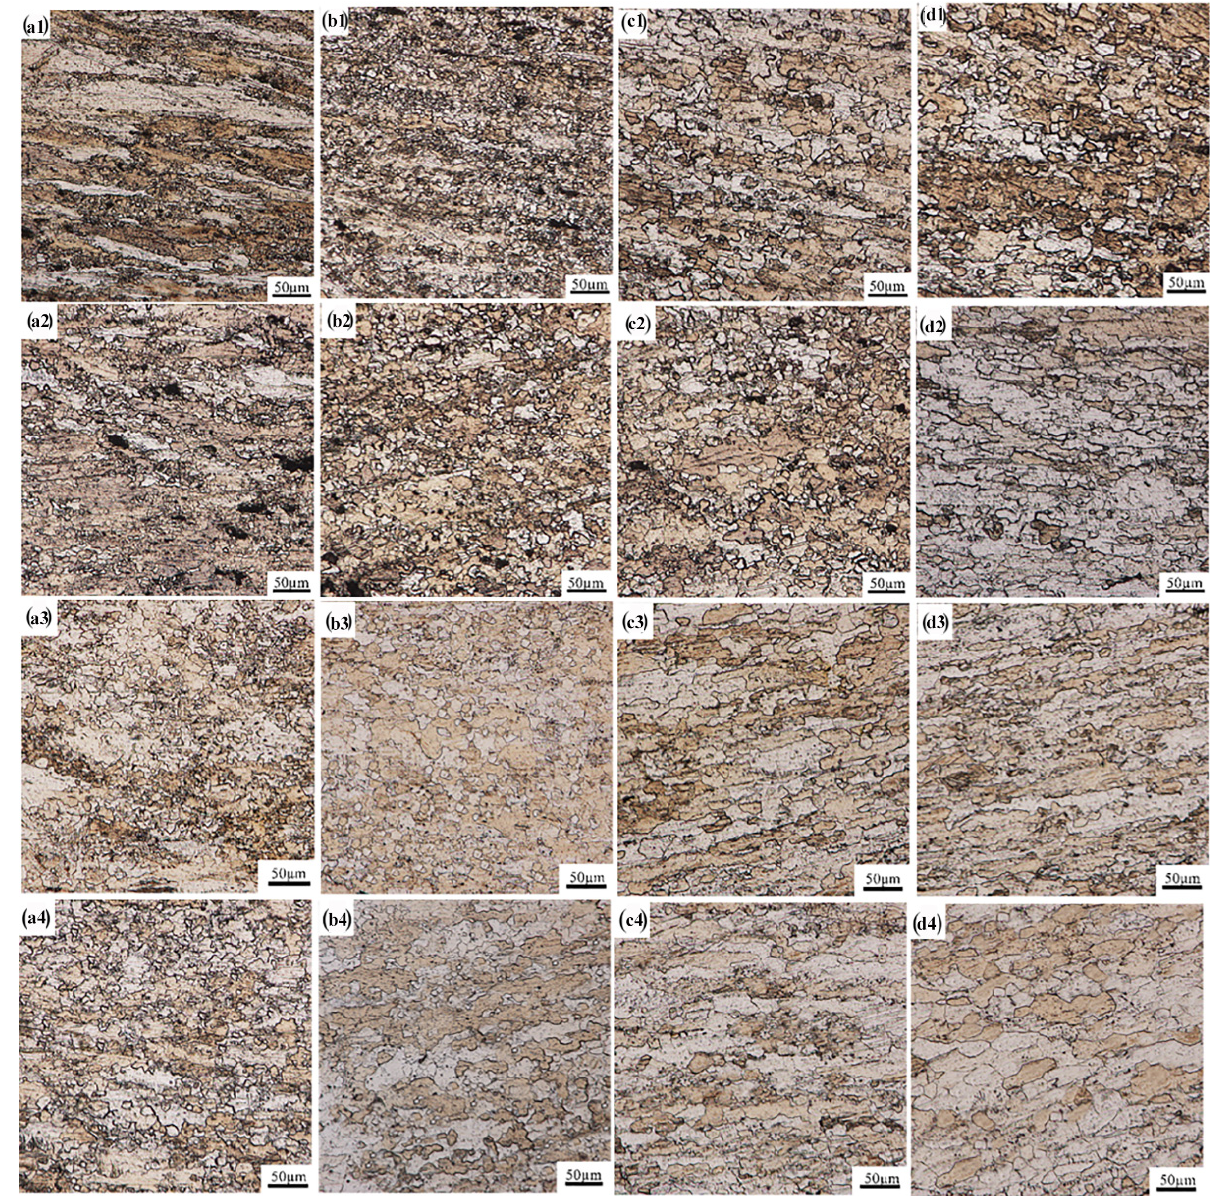
Figure 4. Microstructures of the gauge section of GAZ211 alloy at different deformation temperatures of 573 K ( a1 – a4 ), 623 K ( b1 – b4 ), 673 K ( c1 – c4 ), and 723 K ( d1 – d4 ) and strain rates of 1.67 × 10 − 2 s − 1 ( a1 – d1 ), 1.67 × 10 − 3 s − 1 ( a2 – d2 ), 5 × 10 − 4 s − 1 ( a3 – d3 ), and 1.67 × 10 − 4 s − 1 ( a4 – d4 ). Table 1. Grain sizes and elongations of GAZ211 alloy tensiled at different temperatures and strain rates.